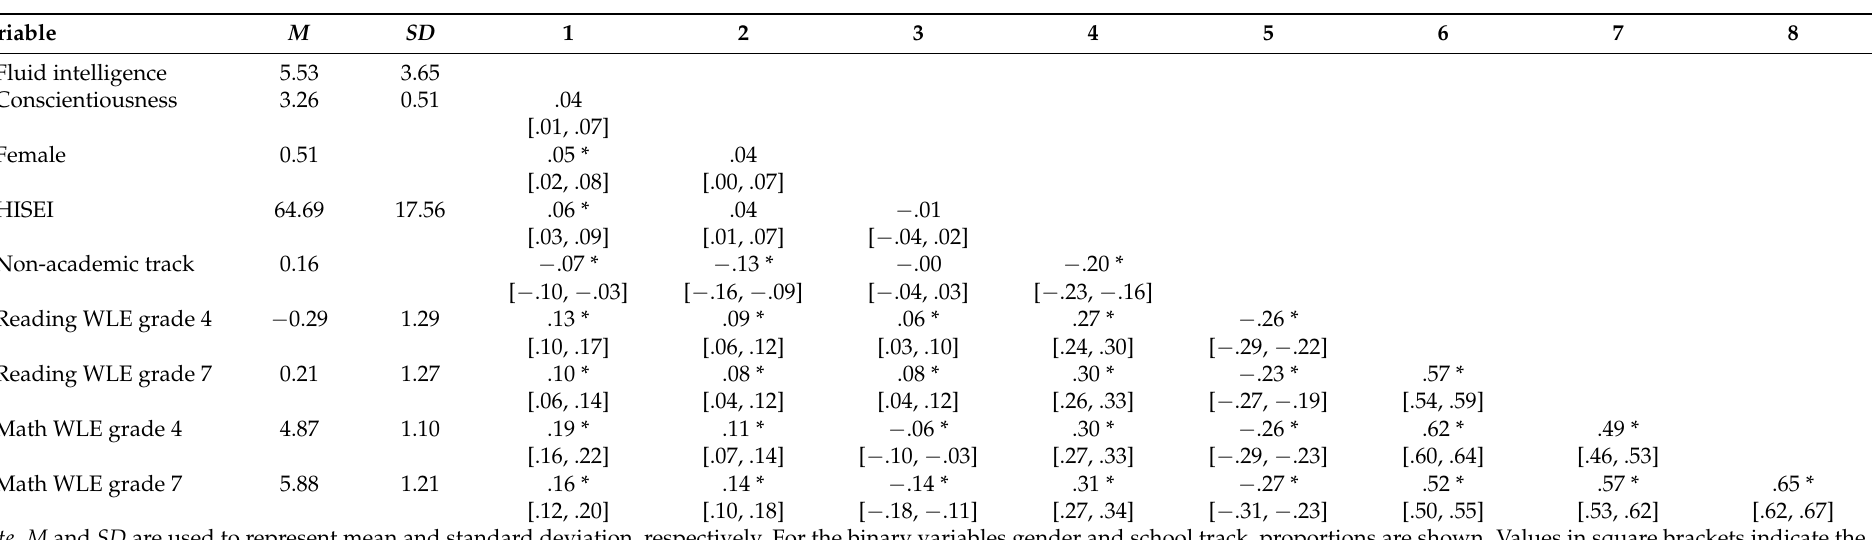
Table 1. Means, standard deviations, and correlations of